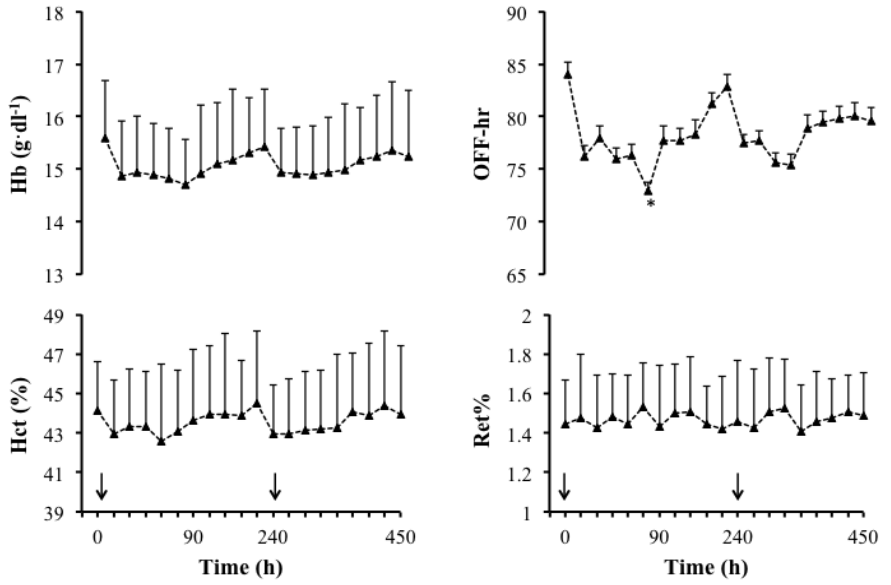
Figure 6. Mean ± S.D. values of Hb concentration (g·dL − 1 ), Hct (%), OFF-hr score and Ret% pre- (0 h) and post-supplementation (2–24 h) of the hyperhydrating solution containing Gly, Cr and Glu. N = 6, ↓ : ingestion of 1st and 2nd solution at 0 h and 4 h, respectively. * Significant ( P < 0.05) difference between pre- and